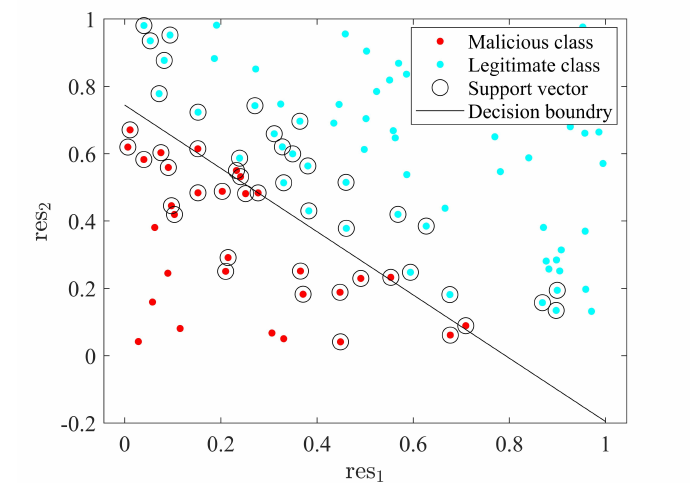
Figure 5. Decision boundary in 2D.